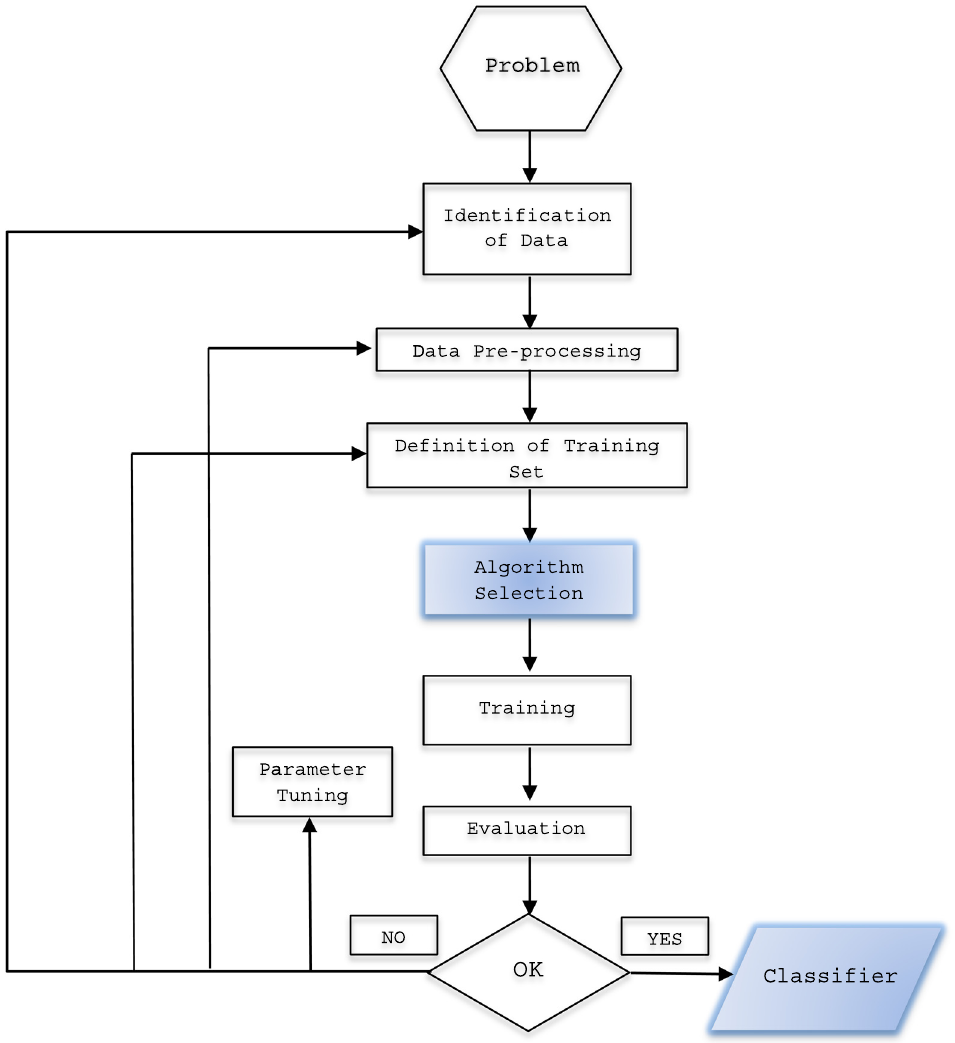
Figure 4: ML supervised